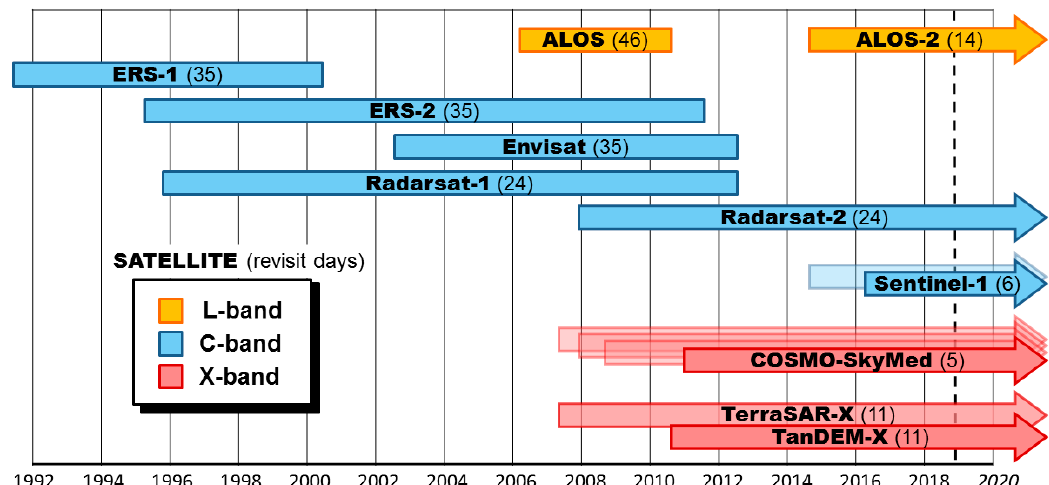
Figure 2. The operating periods of available satellites equipped with SAR sensors and their band as well as revisit time configurations (number in brackets referring to the revisit time in days). L-, C-, and X-band SAR refers to frequency of 1–2 GHz, 4–8 GHz, and 8–12 GHz; wavelength of 30–15 cm, 7.5–3.75 cm, and 3.75–2.5 cm, respectively